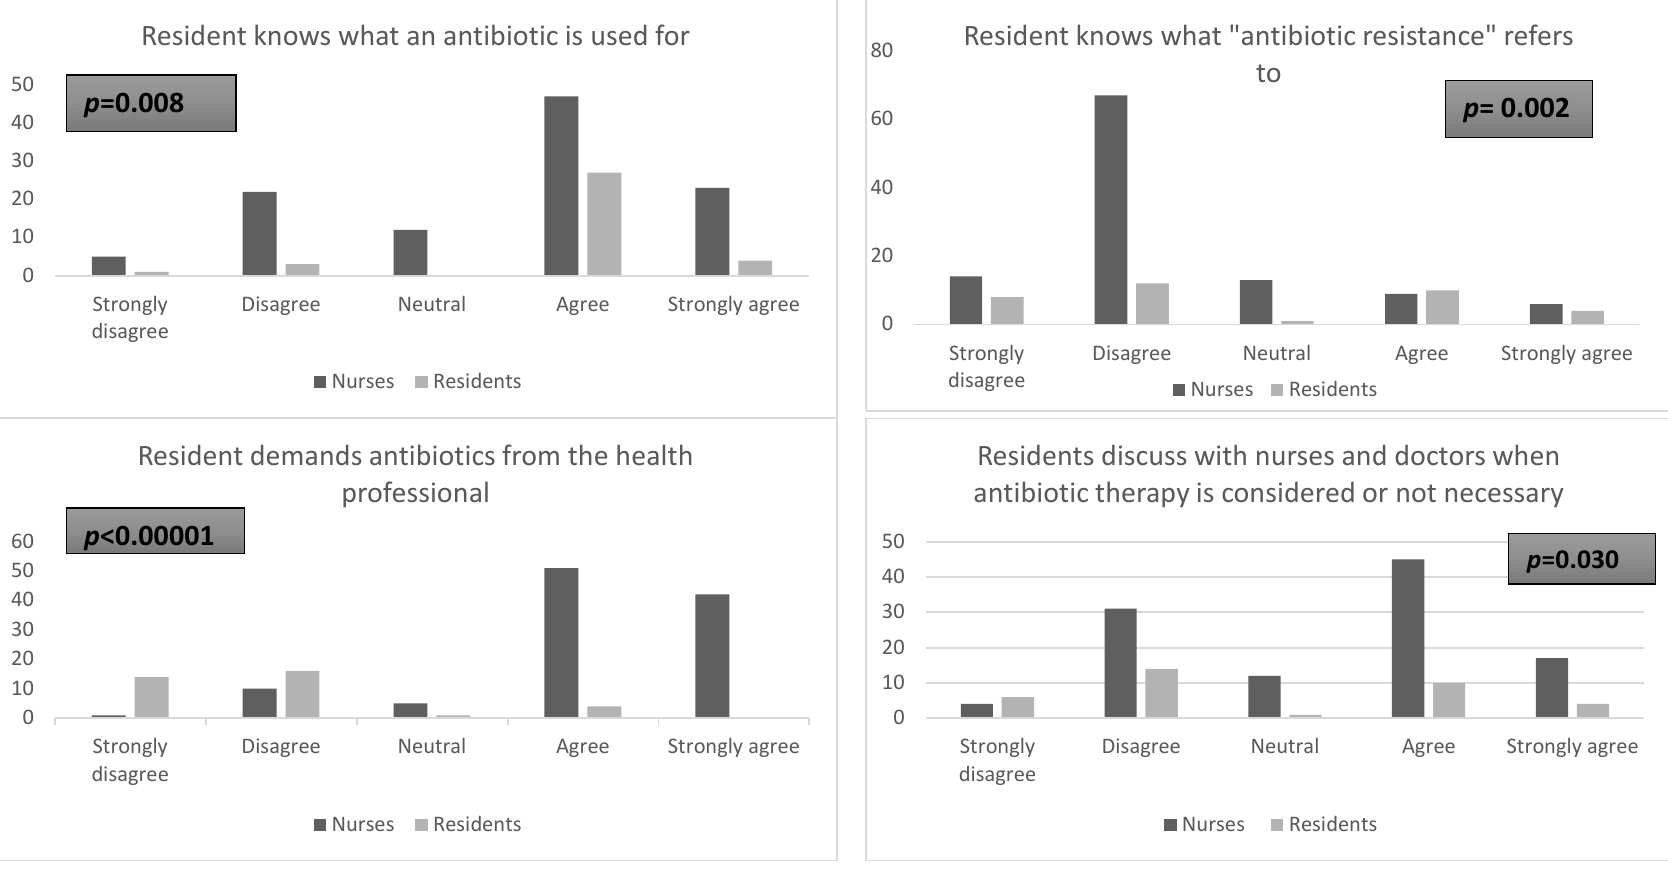
Figure 1. Nurses and residents’ opinions on antibiotics use.